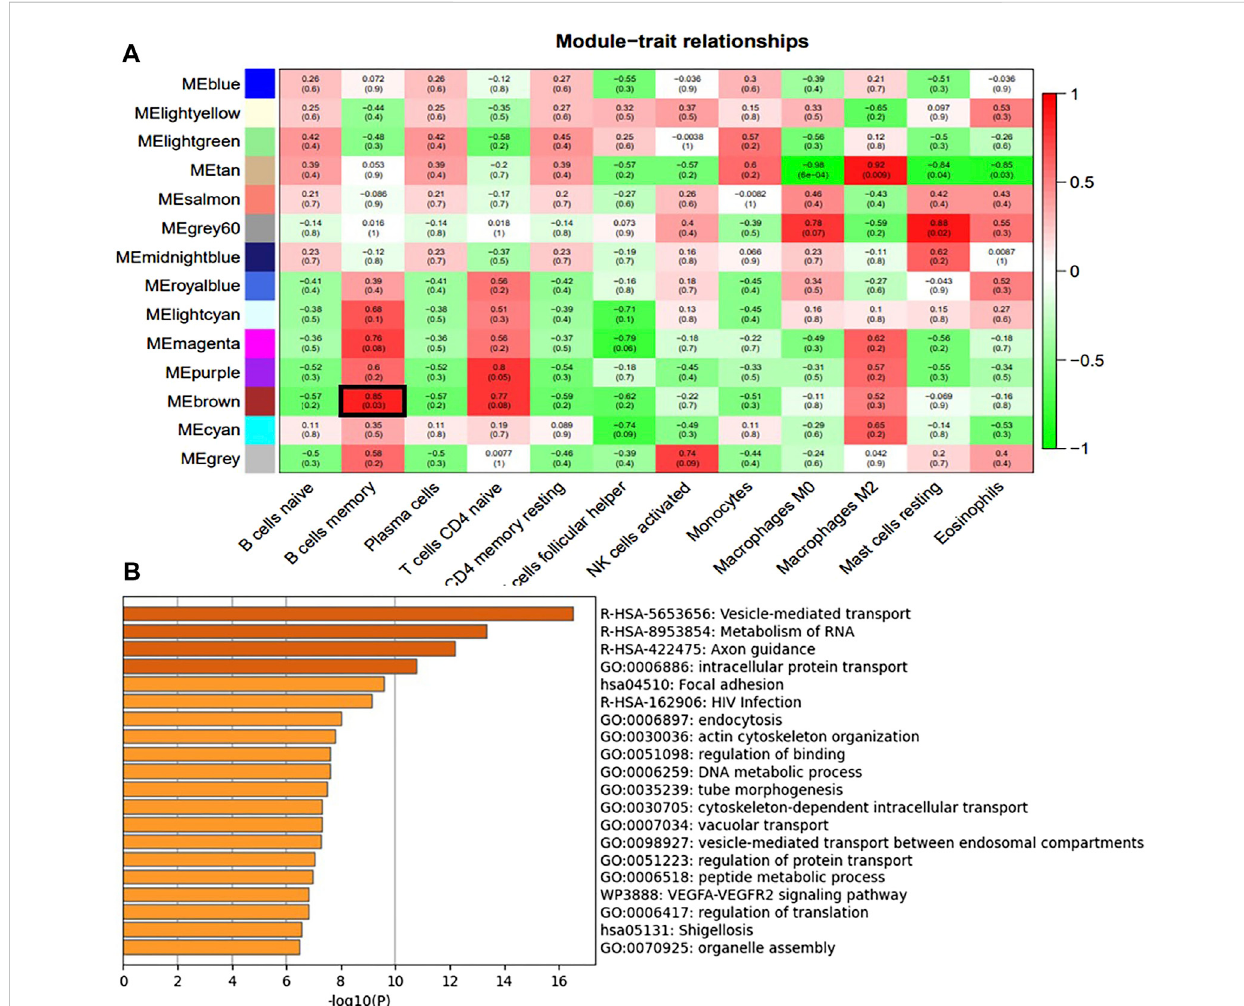
FIGURE 5 Immune cell module and Enrichment Analysis. (A) Correlation between module genes and immune cells (the redder the color, the higher the correlation; Pearson correlation coef fi cient between module characteristic genes and sample characteristic vectors, and the number in brackets represents the corresponding p -value) (B) Enrichment analysis of brown module genes most associated with memory